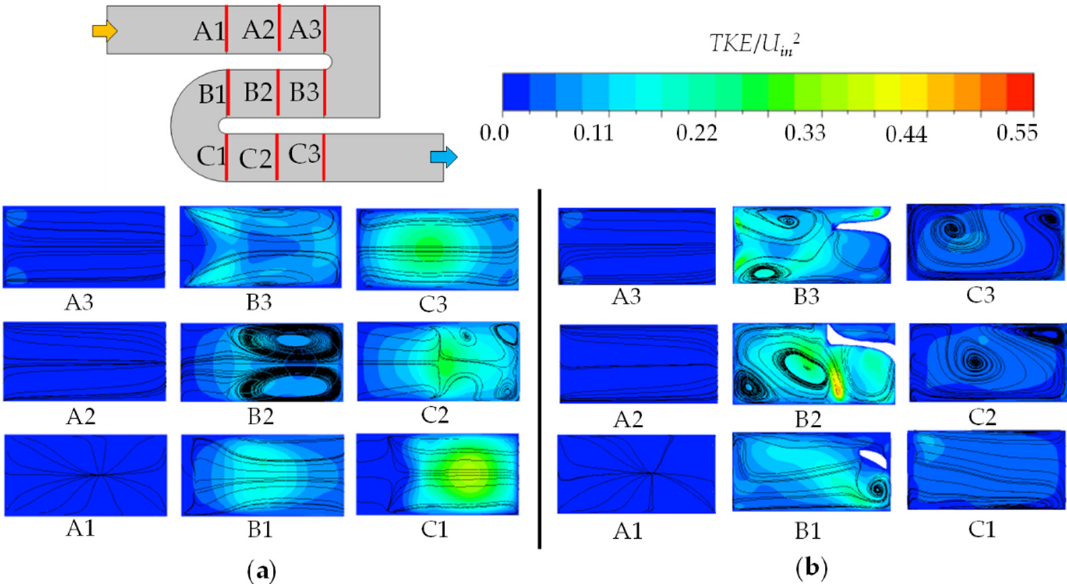
Figure 22. Local dimensionless turbulent kinetic energy and velocity streamline on the cross-sections in the multipass channel: ( a ) baseline model; ( b ) TO model with diamond ‐ TPMS structure.